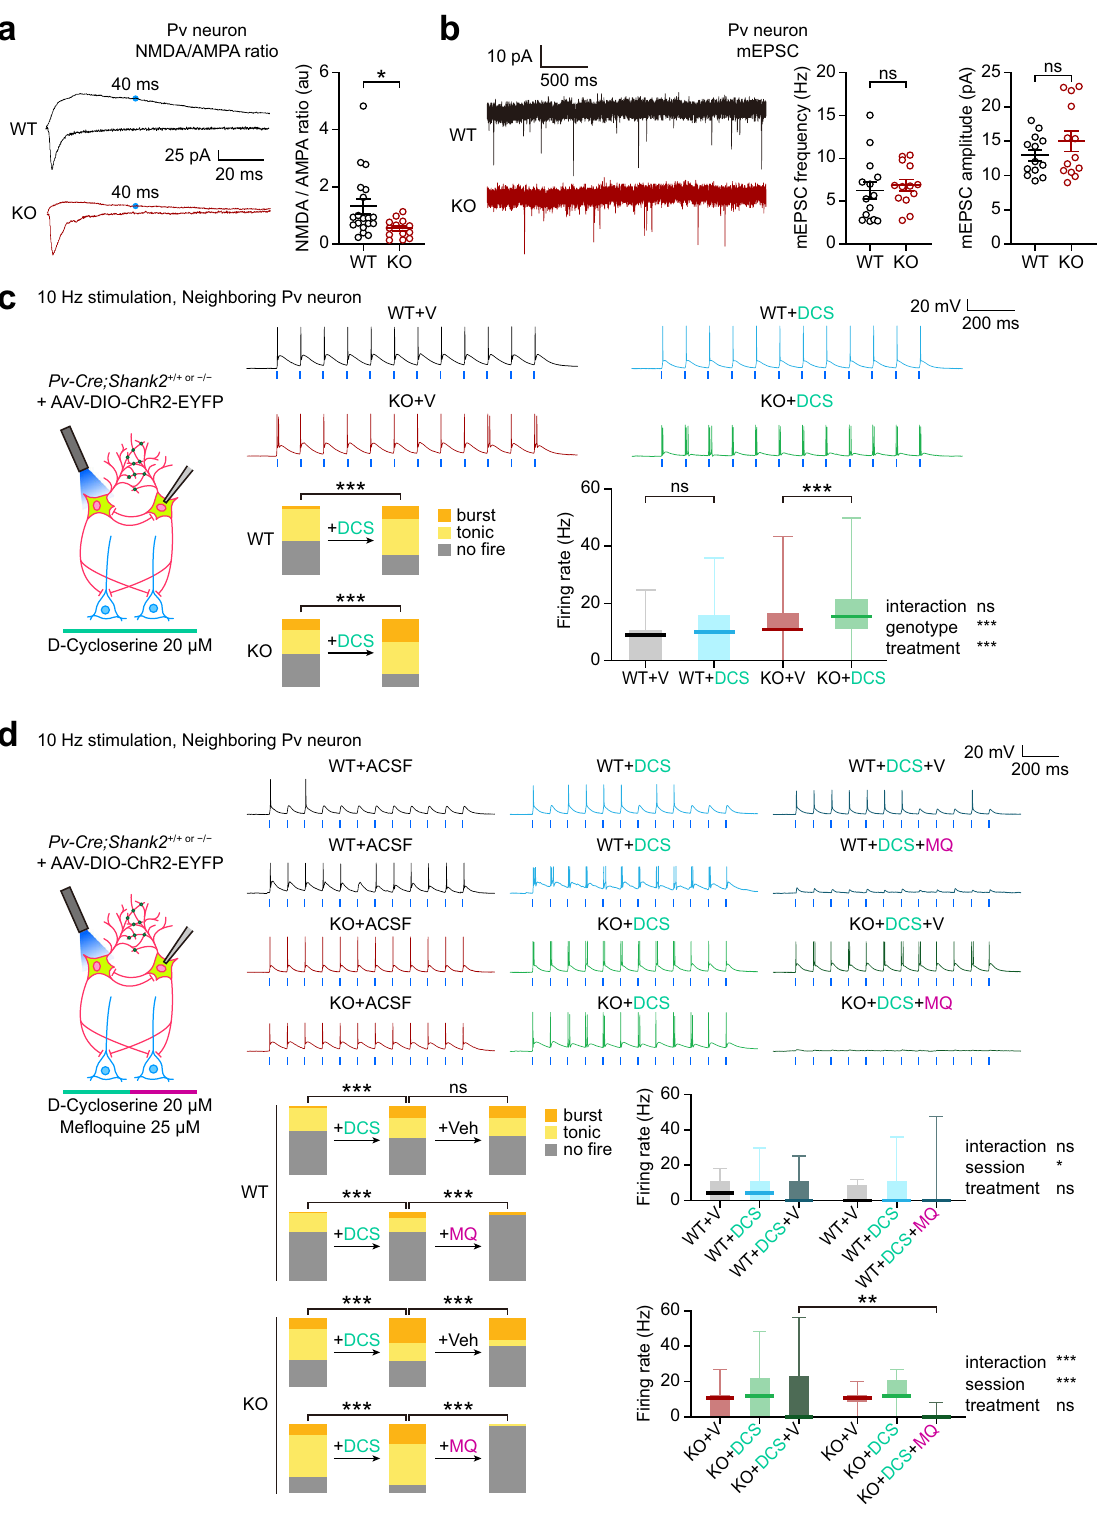
In contrast, Pv neuronal stimulation at 40 Hz, an inef fi cient inducer of bursts in Shank2 – / – Pv neurons, using ChETA (channelrhodopsin-2 containing an E123T mutation) failed to